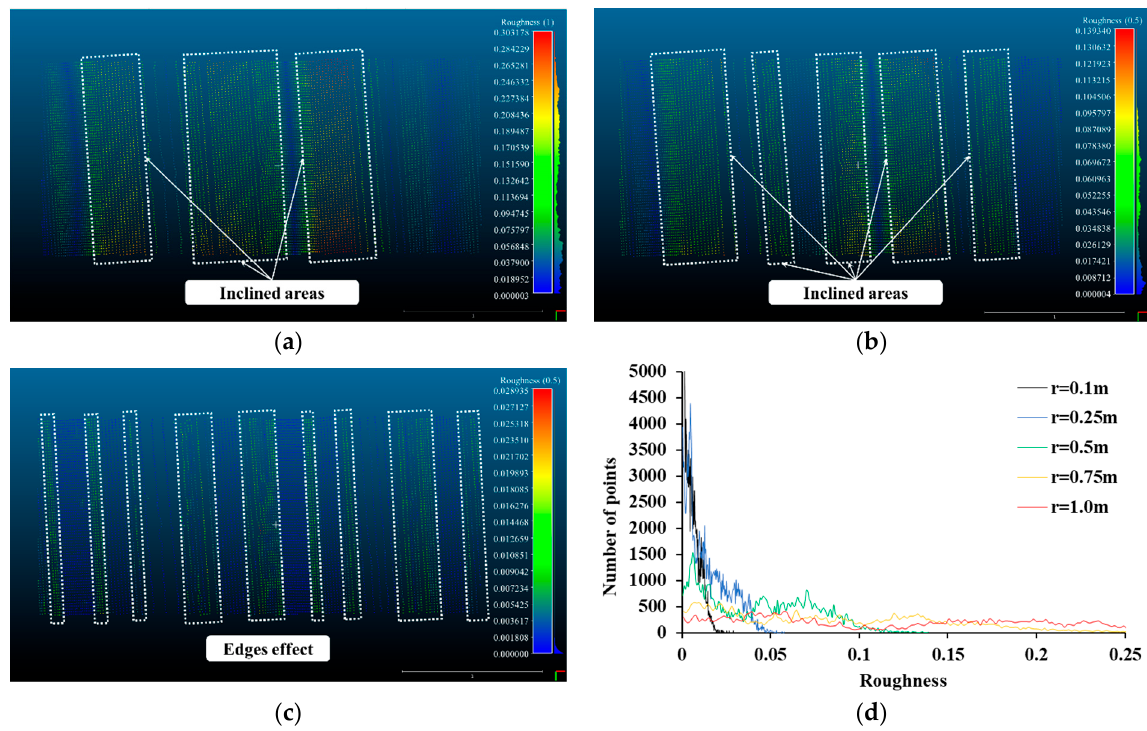
Figure 7. Roughness of sheet pile, ( a ) Kernel radius = 1.0 m, ( b ) Kernel radius = 0.5 m, ( c ) Kernel radius = 0.1 m, ( d ) Histogram of roughness.